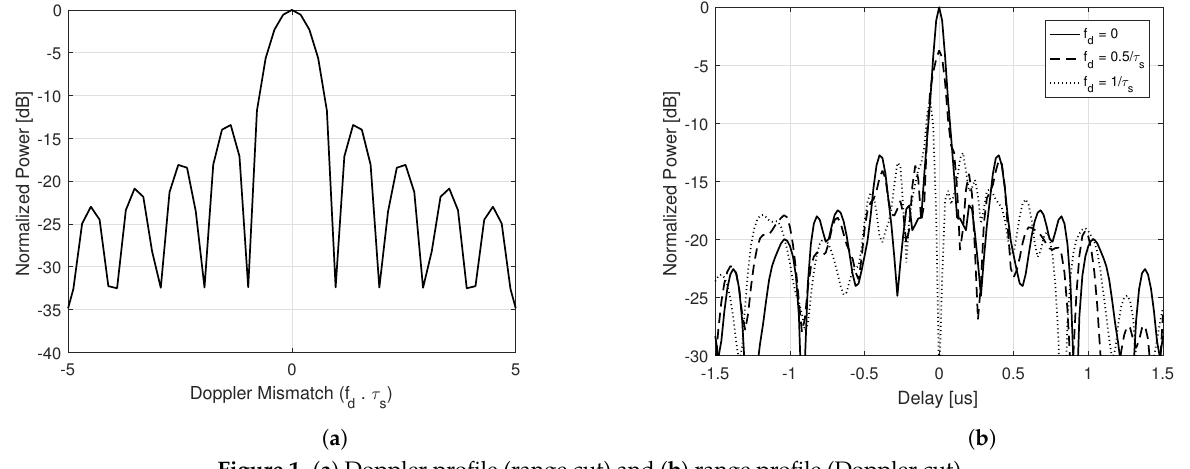
Figure 1. ( a ) Doppler profile (range cut) and ( b ) range profile (Doppler cut). Since the Doppler tolerance of PM/FM Noise waveforms are independent of their range profile, the remainder of this paper addresses only the latter. The system’s perfor- mance, being a function of R ˜ s ( τ ) , is also function of R θ ( τ ) . The autocorrelation function of the random process characterizing the phase of the transmit signal, according to the Wiener–Khintchine theorem, is obtained by the Fourier transform of its Power Spectral Density, S θ ( f ) , which, in turn, is given by